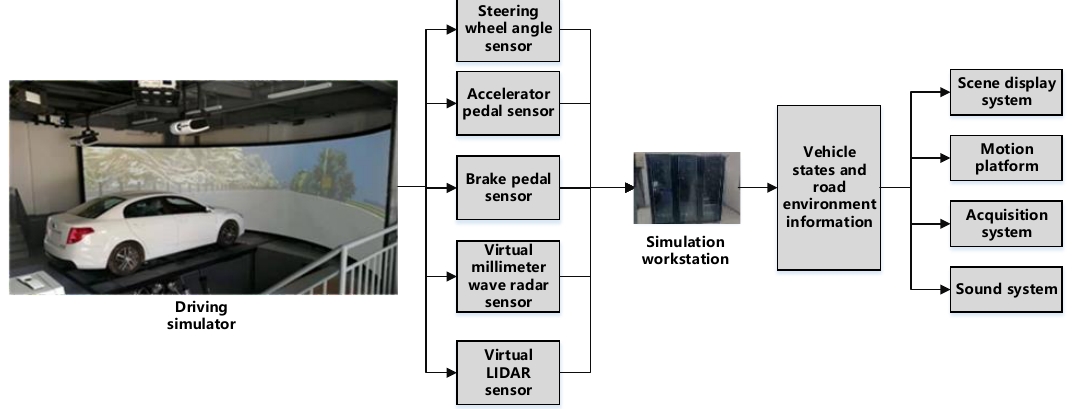
Figure 7. Composition of the driving simulator.